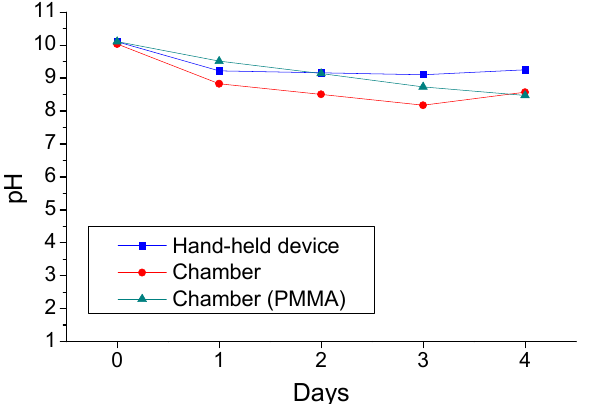
Figure 4. Surface pH values of coated concrete and PMMA specimens, during the application of different acid spraying tests.